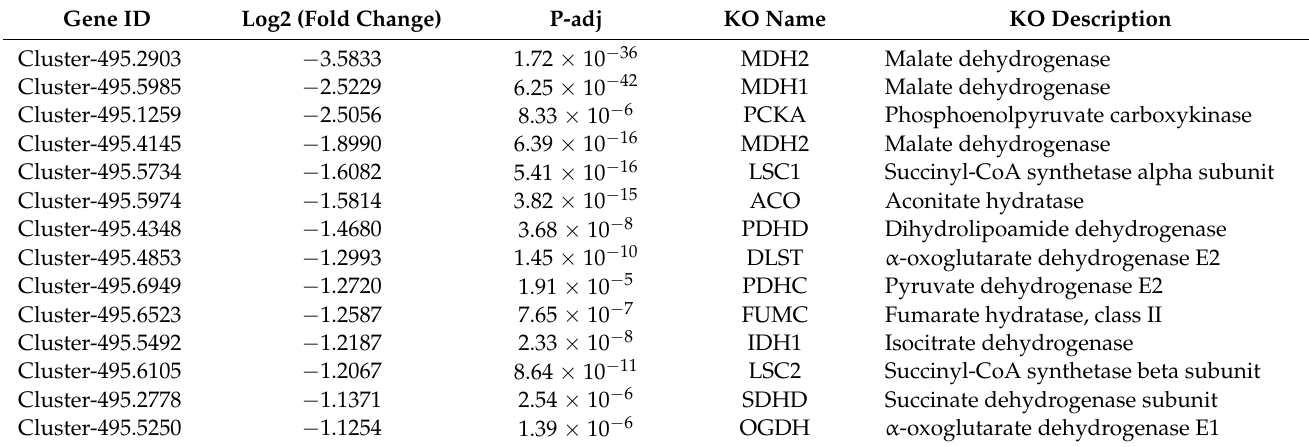
Table 4. Differentially expressed genes in the TCA